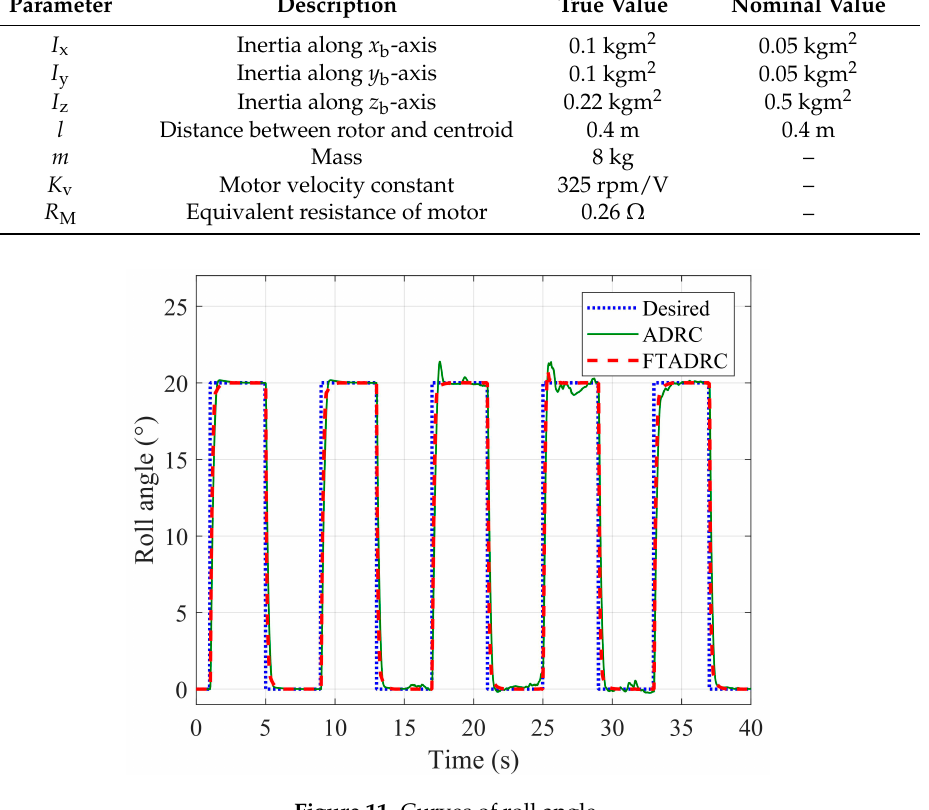
Figure 11. Curves of roll angle.